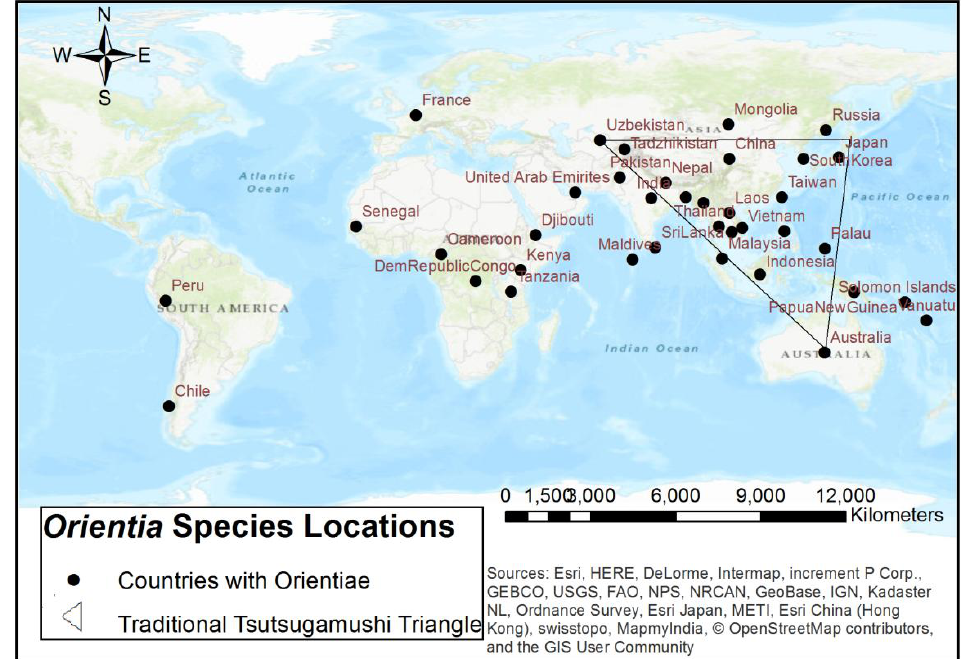
Figure 1. Distribution of Orientia species both within and beyond the endemic Tsutsugamushi Triangle.